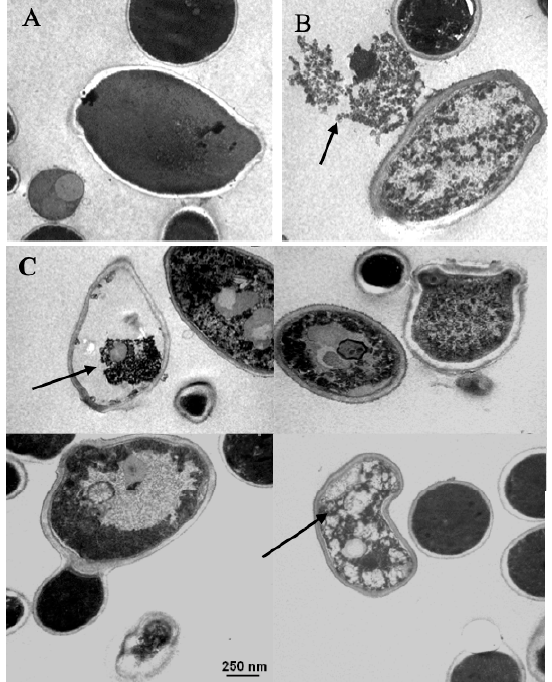
Figure 6. Transmission electron microscopy (TEM) of Candida albicans ATCC 90028 yeast. ( A ) Assembly of untreated yeasts, where the total number observed was 36 cells (control group). ( B ) and ( C ) Assembly of treated yeasts, where the total number observed was 33 cells with 500 µM of limonene. Arrows indicate rupturing of the cell wall and different intracellular disorders probably induced by limonene treatment. Three samples per group were used. Scale bar = 250 nm.